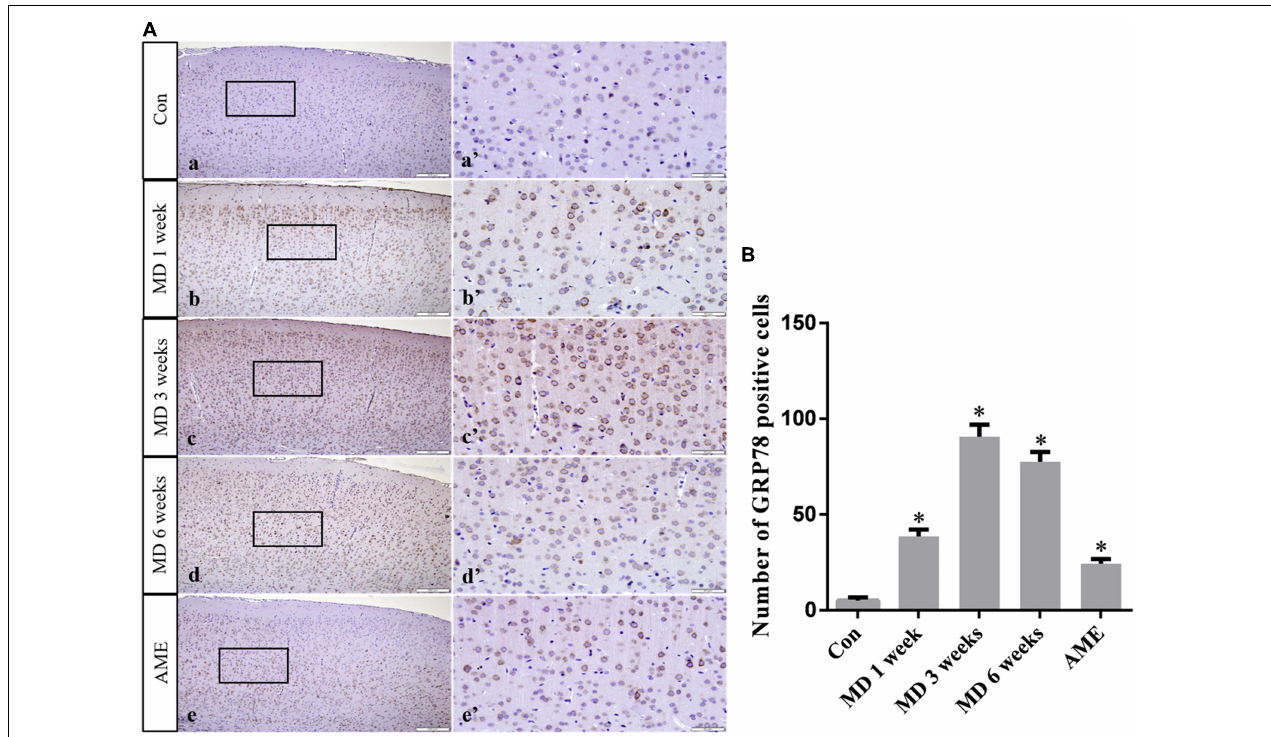
FIGURE 4 | (A) Representative images showing GRP78 immunohistochemistry in the cortex. Panels (a’–e’) are magnified areas of panels (a–e) . Bars = 200 µ m in panels (a–e) . Bars = 50 µ m in panels (a’–e’) . (B) Quantitative analysis of the number of GRP78 positive cells. The data are shown as mean ± SD, * P < 0.05 vs. control group ( n = 6). MD, morphine dependence; AME, acute morphine